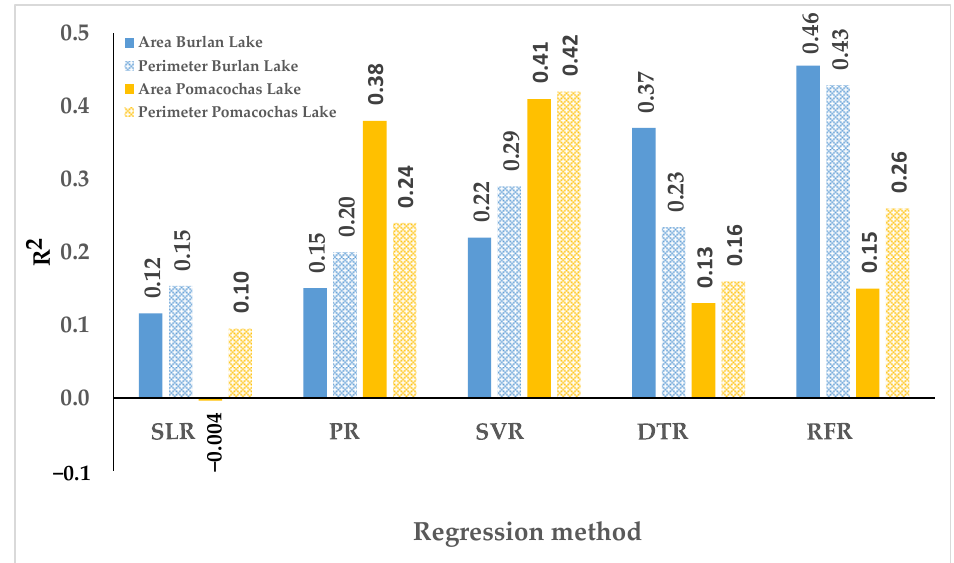
Figure 10. Comparison of the R 2 calculated for the models of SLR, PR, SVR, DTR, and RFR.